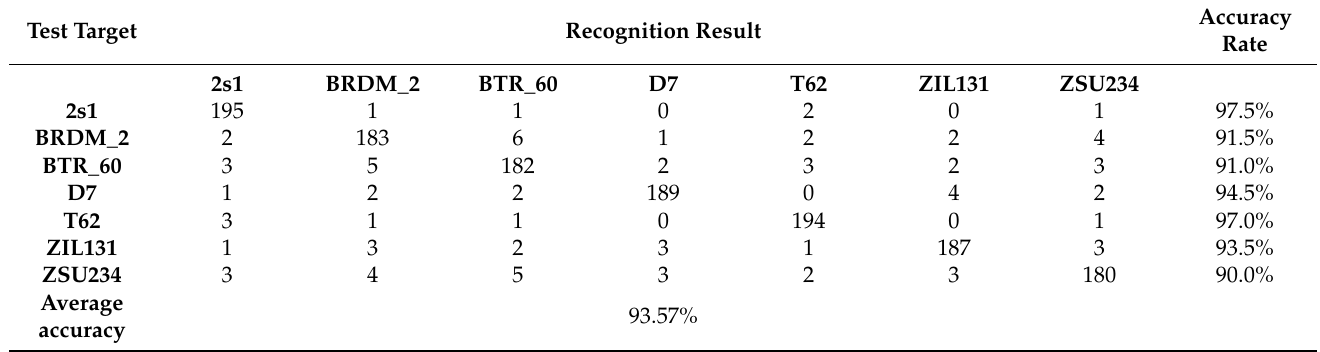
Table 10. Target recognition results with pretraining and loss function improvement (mixed tar- gets